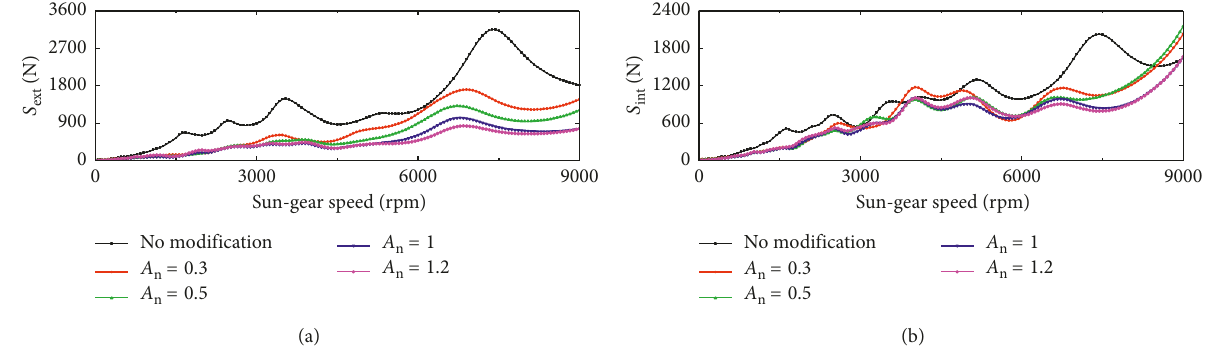
Figure 12: Dynamic tooth loads on external and internal meshes versus sun-gear speed influence of the normalized modification angle: (a) sun-planet meshes and (b) ring-planet